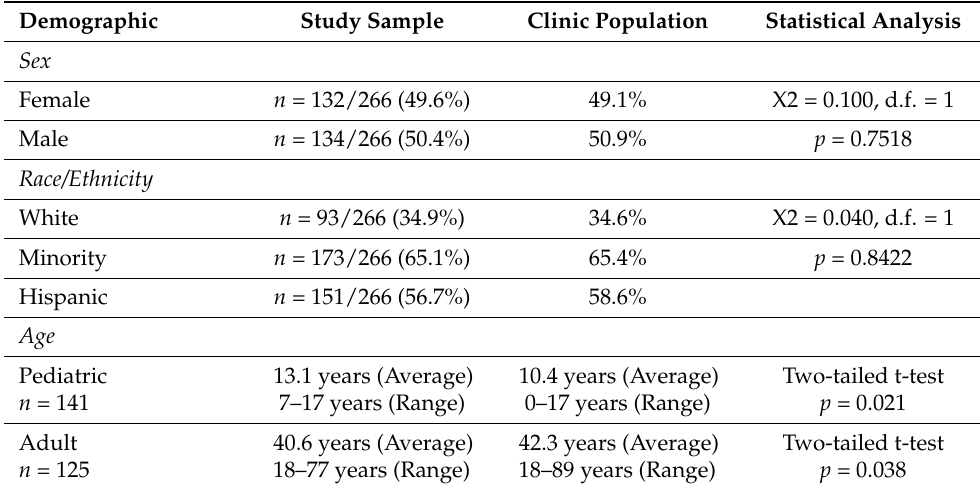
Table 1. Demographic analysis of study sample.